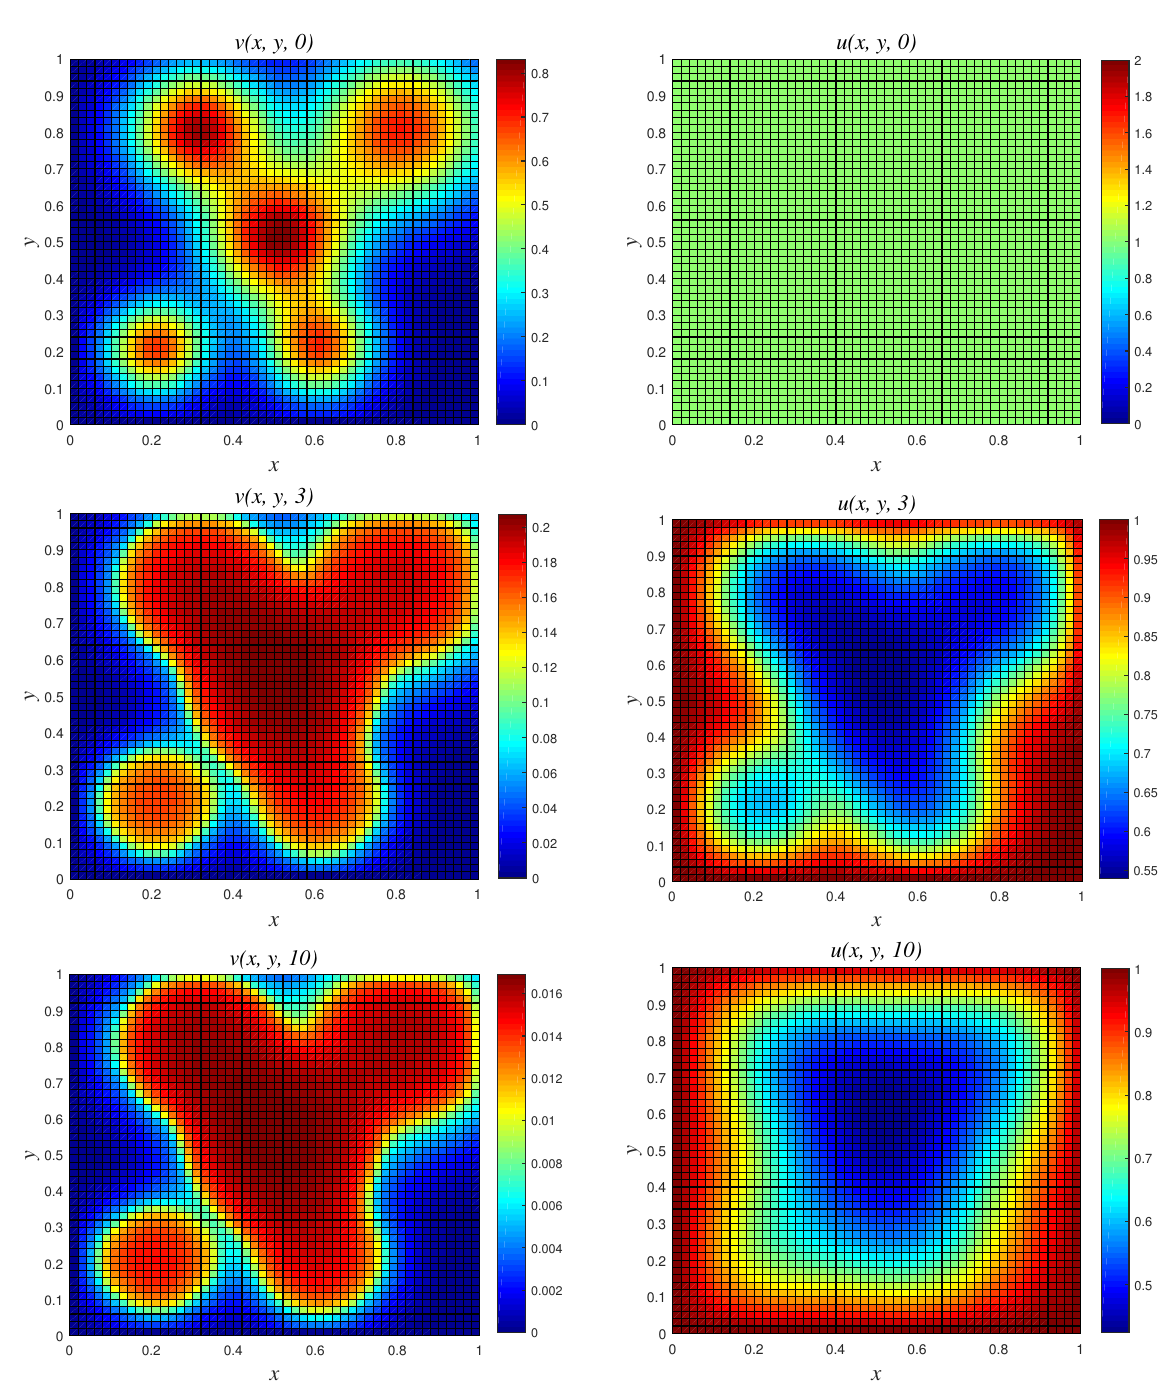
Figure 9. 3D plots of numerical solution vs. x vs. y using NSFD2 scheme at times t = 0,3 and 10. We used spatial step sizes h x = h y = 0.02 and time step k =